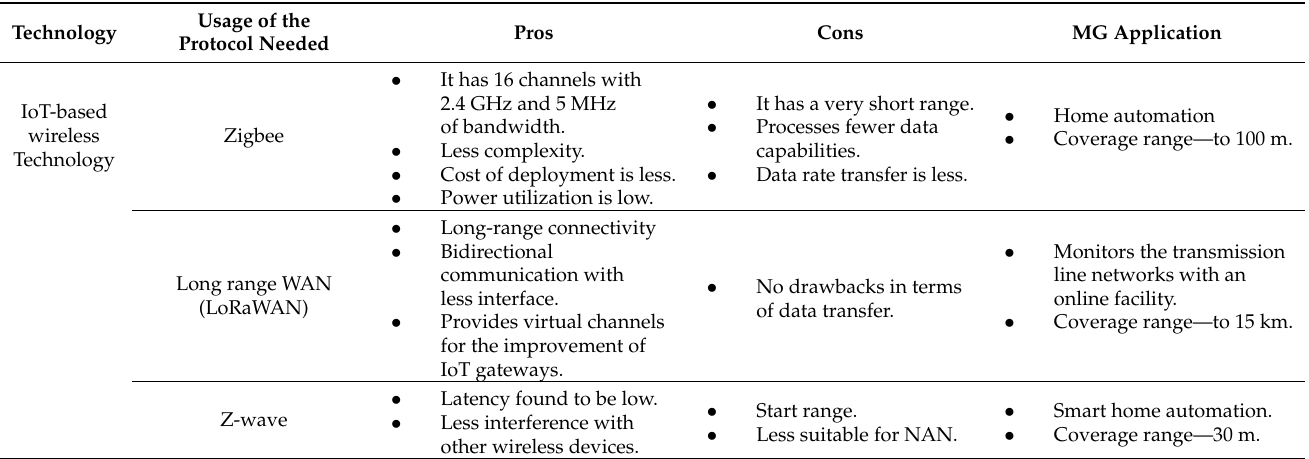
Table 9. Wireless technology based on the IoTs with an MG coverage